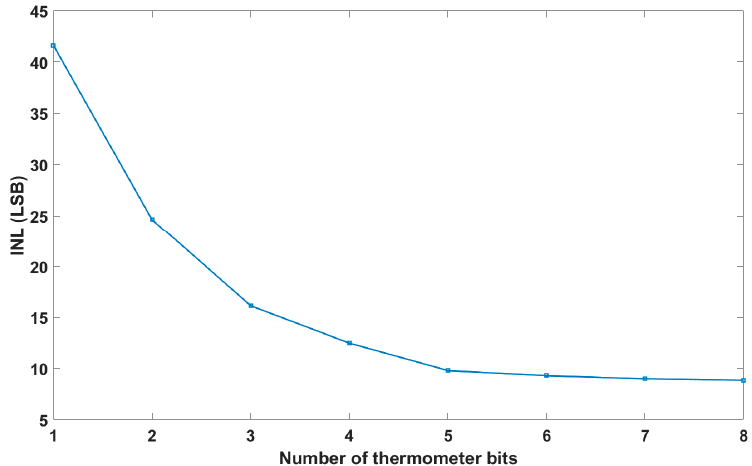
Figure 8. ADC linearity versus the number of thermometer bits.